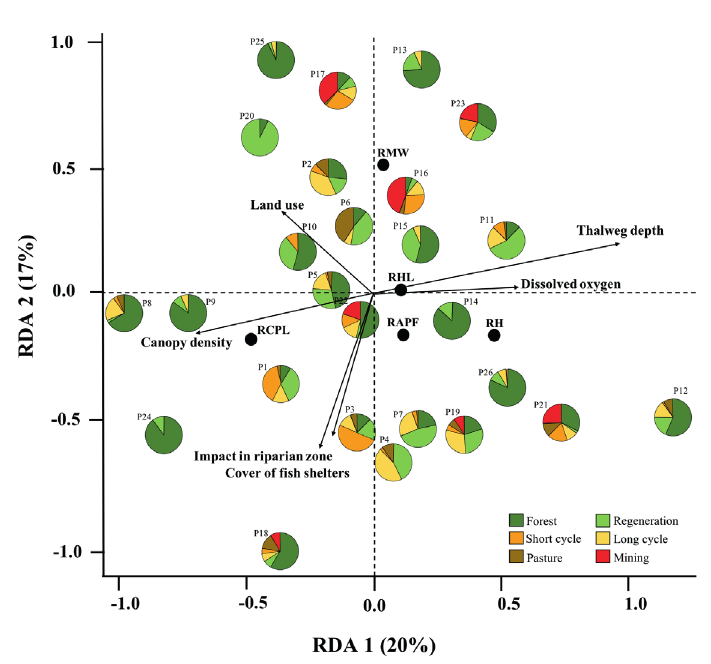
FIGURE 4 | Relationships between the ecomorphological traits of fish species and environmental variables (land use and local habitat) in the streams evaluated in this study. Traits are represented by labels: relative head length (RHL), relative mouth width (RMW), relative height (RH), relative area of pectoral fin (RAPF) and relative caudal peduncle length